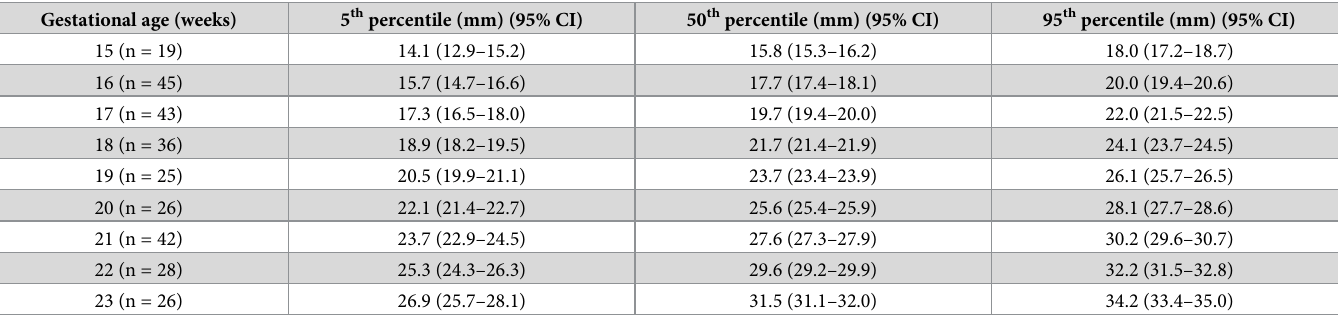
Table 5. Reference range of mandible length (ML) as estimated by the quantile regression analysis with 95% confidence interval along gestational age (N = 290). Gestational age (weeks)